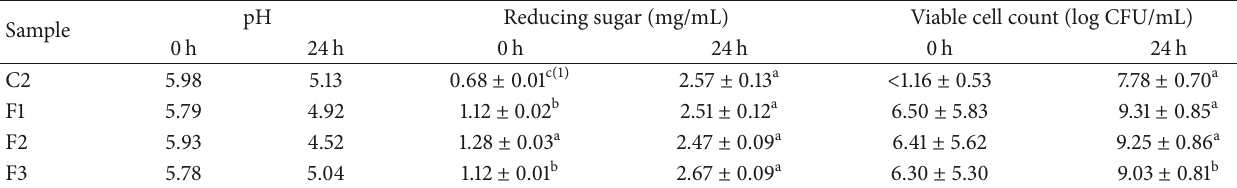
Table 1: Change of pH, reducing sugar, and viable cells before and after